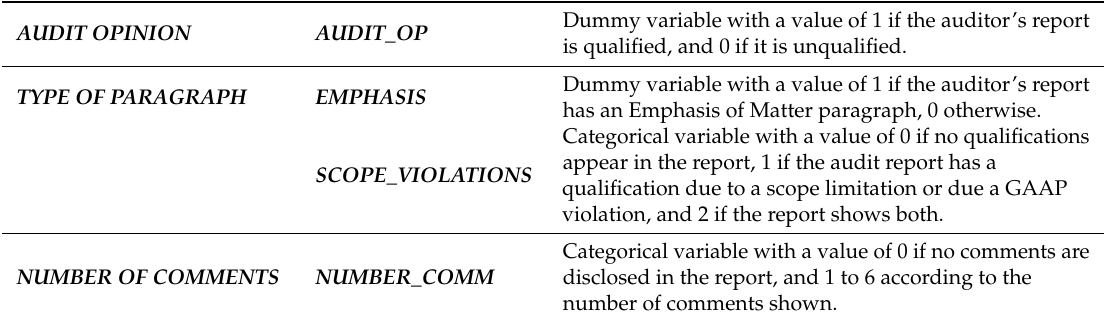
Table 2. Classification and description of the audit report variables in this